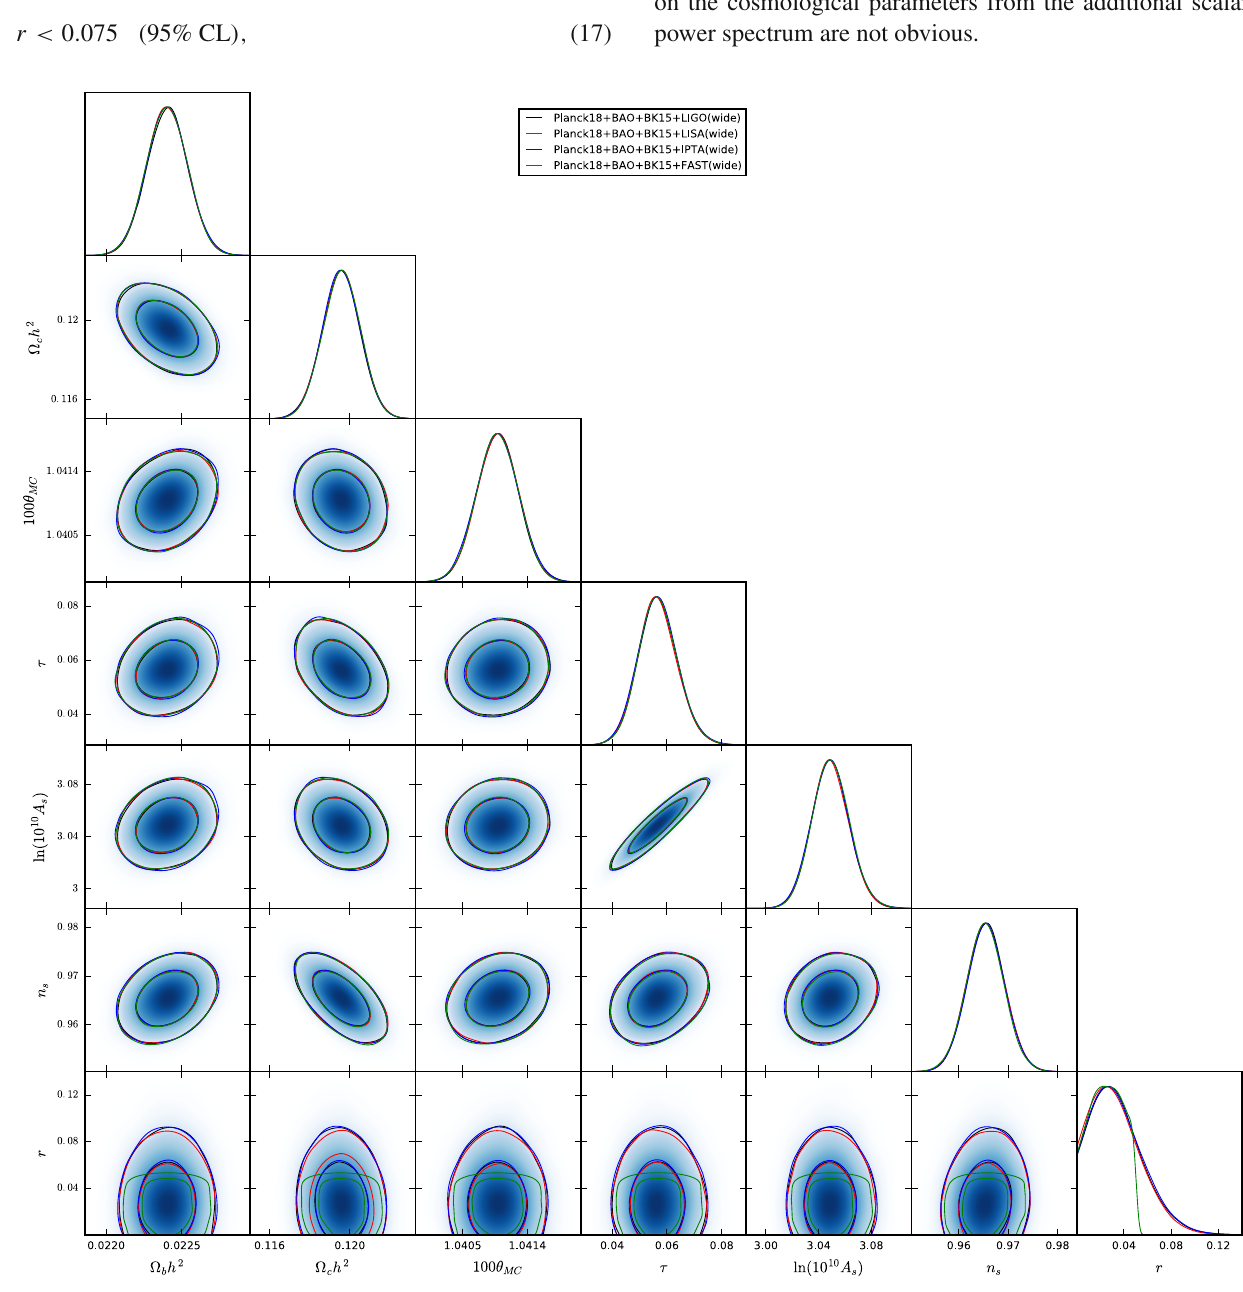
Fig. 6 The contour plots and the likelihood distributions for the cosmological parameters in the (cid:2) CDM+ r model at the 68% and 95% CL from the combinations of Planck18+BAO+BK15+LIGO w , Planck18+BAO+BK15+LISA w , Planck18+BAO+BK15+IPTA w , Planck18+BAO+BK15+FAST w ,